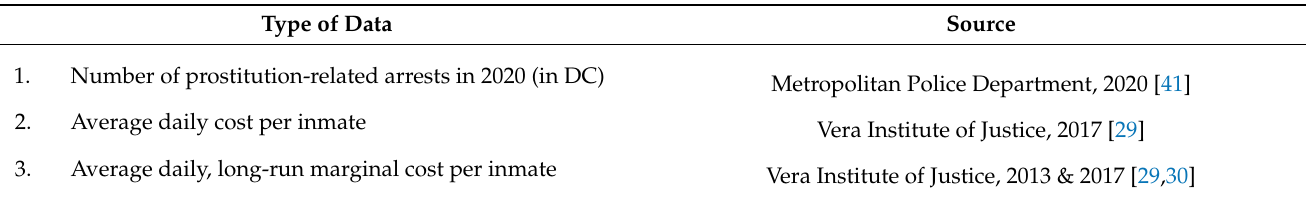
Table 8. Sources of data used to calculate criminal justice system savings following decriminalization.